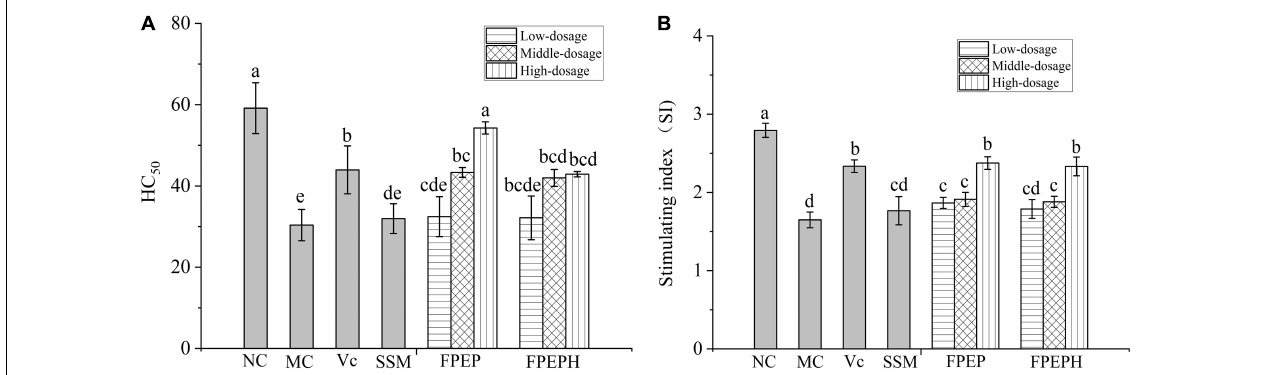
FIGURE 4 | Effects of sour soybean milk on serum hemolysin and splenic lymphocyte proliferation. (A) HC 50 , and (B) SI. Data were presented as the Mean ± S.D. The same letters indicated no significant differences and different letters indicated significant differences at P < 0.05. NC: control group; MC: model group; Vc: vitamin C-ascorbic acid; SSM: sour soybean milk; FPEP: fermented with P. eryngii polypeptides with a molecular weight of < 3 kDa; FPEPH: fermented with P. eryngii protein hydrolysate.